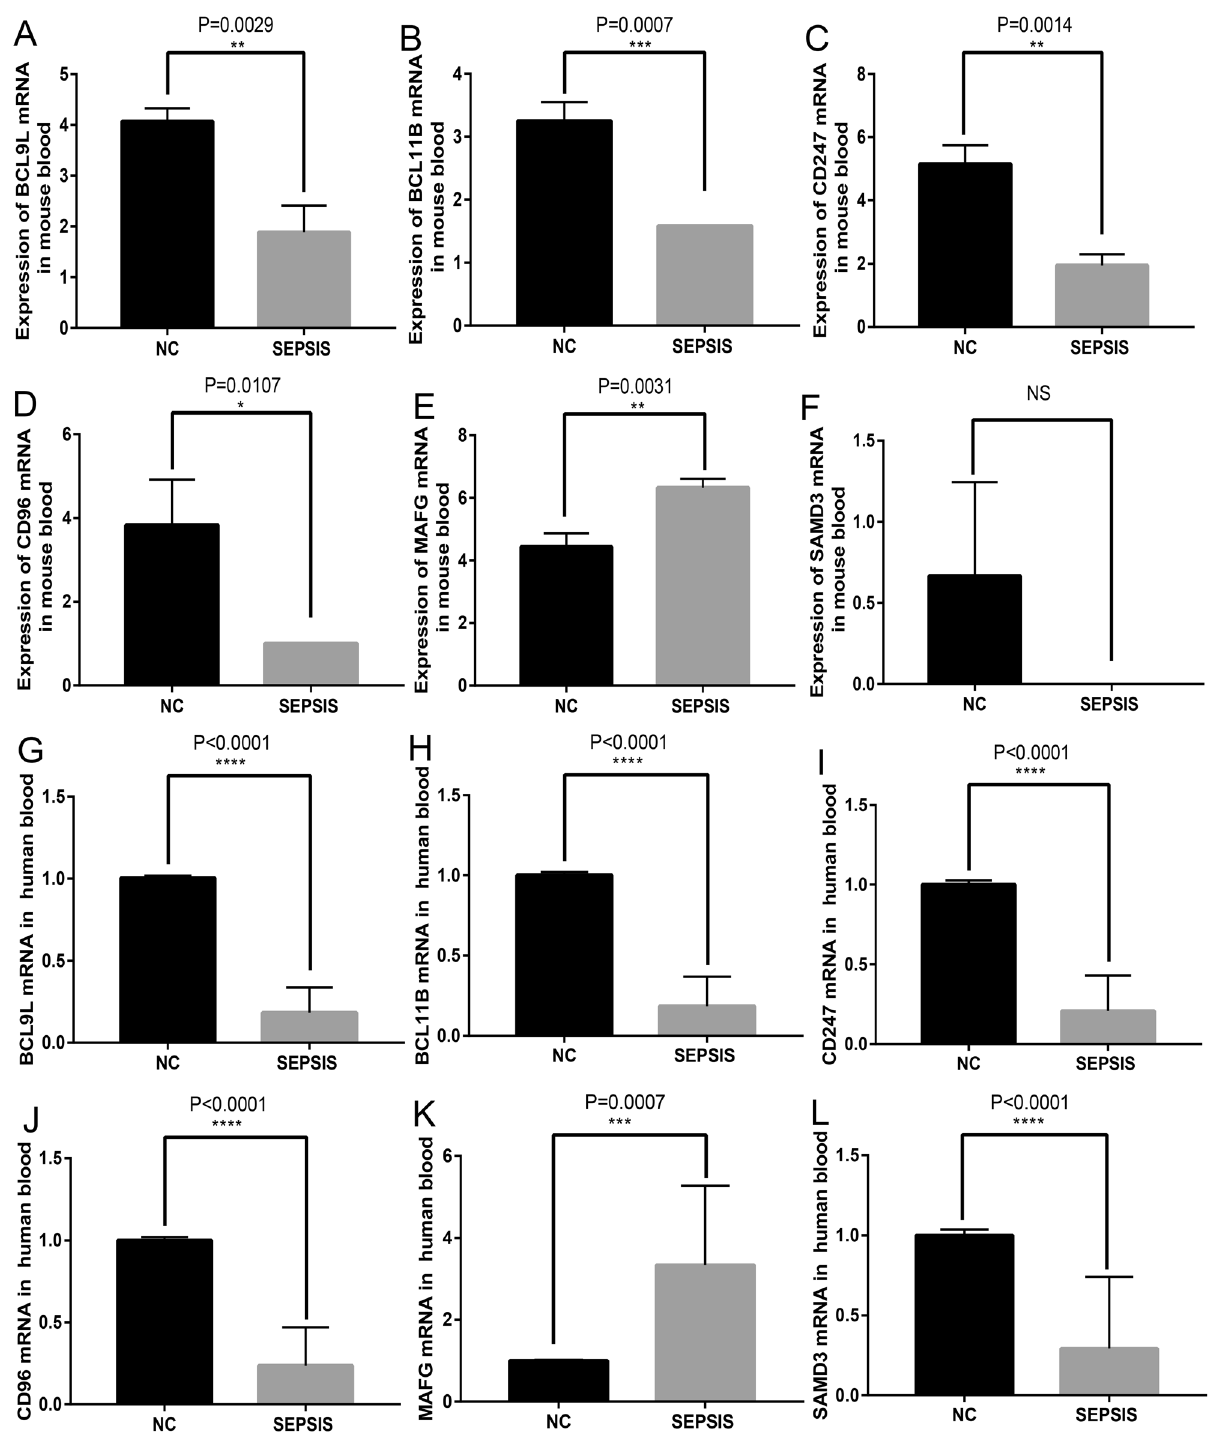
Figure 6. Expression tendency of key genes. ( A – F ) showed the statistical analysis of expression values of BCL9L, BCL11B, and CD247, CD96, MAFG, and SAMD3, in septic mouse peripheral blood measured by sequencing, respectively. The results demonstrated that these 5 genes were down-regulated in the peripheral blood of septic mice, while MAFG was up-expressed. ( G – L ) demonstrated the expression of BCL9L, BCL11B, and CD247, CD96, MAFG, and SAMD3 on human peripheral blood, which measured by